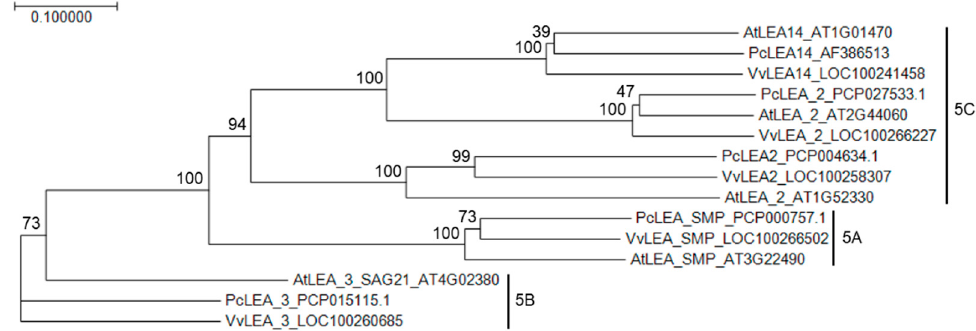
Figure 1. A phylogenetic tree based on the amino acid sequences of PcLEA14 (AF386513) and group 5 late embryogenesis abundant (LEA) proteins from Arabidopsis, P. communis and V. vinifera : The tree was constructed using the neighbor-joining method after sequence alignment using ClustalW2, with Genetyx version 14 (GENETYX CO., Tokyo, Japan). Branch numbers refer to the percentage of replicates that support the branch using the bootstrap method (1000 replicates). The scale bar corresponds to 0.1 amino acid substitutions per residue.